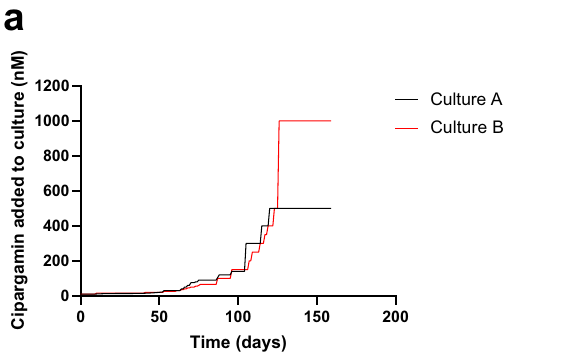
Fig.1|Generationofparasiteswithhigh-levelcipargaminresistancefromDd2- PfATP4 T418N,P990R parasites having low-level resistance. a Dd2-PfATP4 T418N,P990R parasites were exposed to incrementally increasing concentrations of cipargamin. Twoindependentselectionswereperformed(showninredandblack). b Inhibition of parasite proliferation by cipargamin in Dd2 parasites (black circles), Dd2-